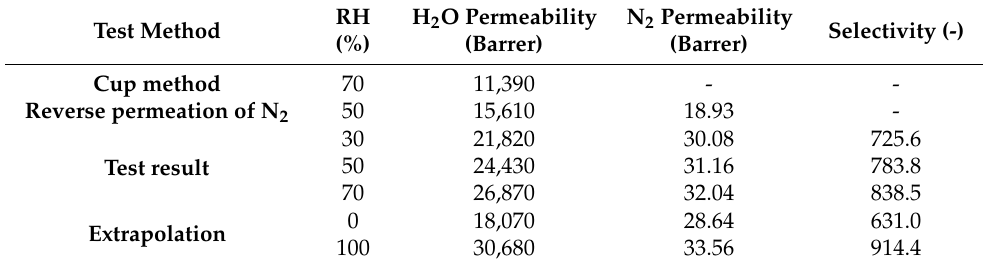
Table 6. Membrane performance factors from this study.